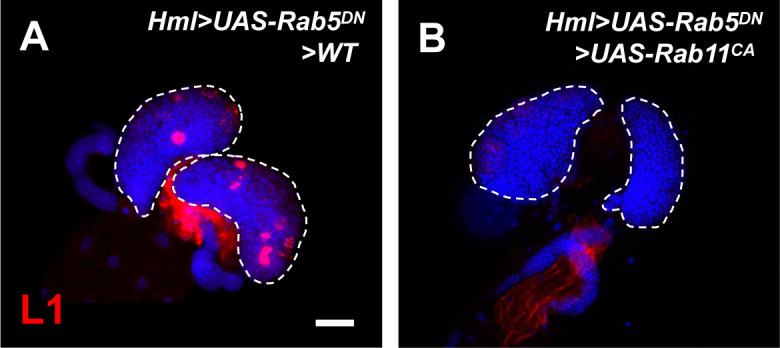
Active Rab11 GTPase activity could restore the aberrant lamellocyte differentiation in lymph glands after inhibition of Rab5.(A and B) Immunostaining of lamellocytes was performed with anti-L1 antibodies. The increased lamellocyte count was rescued in Hml>UAS-Rab5DN>UAS-Rab11CA lymph glands. Scale bar: 50 μm.